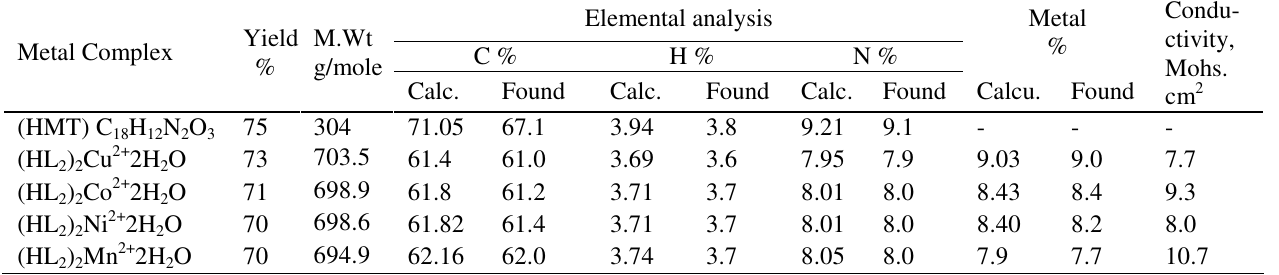
Table 1 . Physical and analytical data of ligand and their metal complexes.